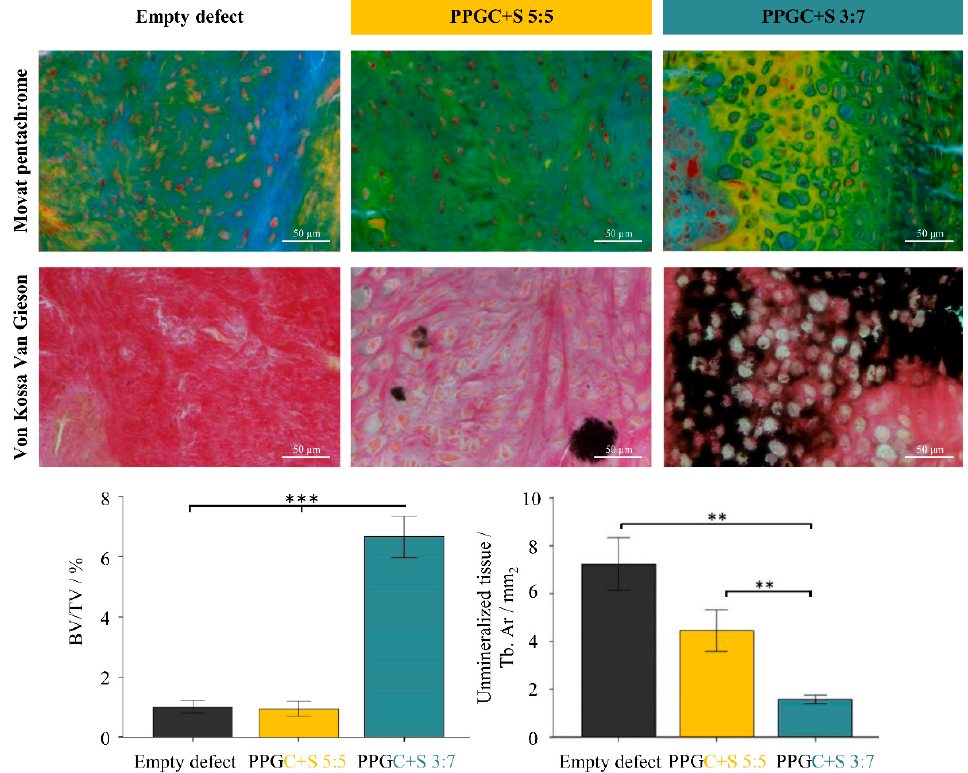
Figure 8. Histological and Histomorphological analysis of Movat pentachrome and von Kossa/van Gieson stained Technovit-embedded sections of the empty defect, PPGC + S 3:7 and PPGC + S 5:5 groups. Pictorial representation of Movat pentachrome staining depicting the highest bone formation and chondrogenic differentiation in PPGC + S 3:7. Moreover, an increase in the mineralized tissue (black) seen in PPGC + S 3:7 as revealed by the von Kossa/van Gieson staining. Histomorphometrical analysis confirming the highest bone formation (BV/TV) and the least unmineralized tissue in PPGC + S 3:7. Asterisks indicate statistical significant differences (* p < 0.05; ** p < 0.01; *** p < 0.001).